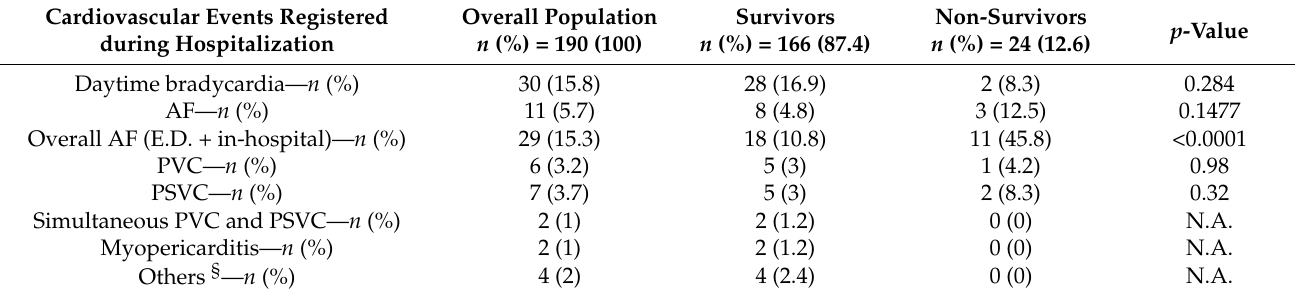
Table 3. Cardiovascular events registered during